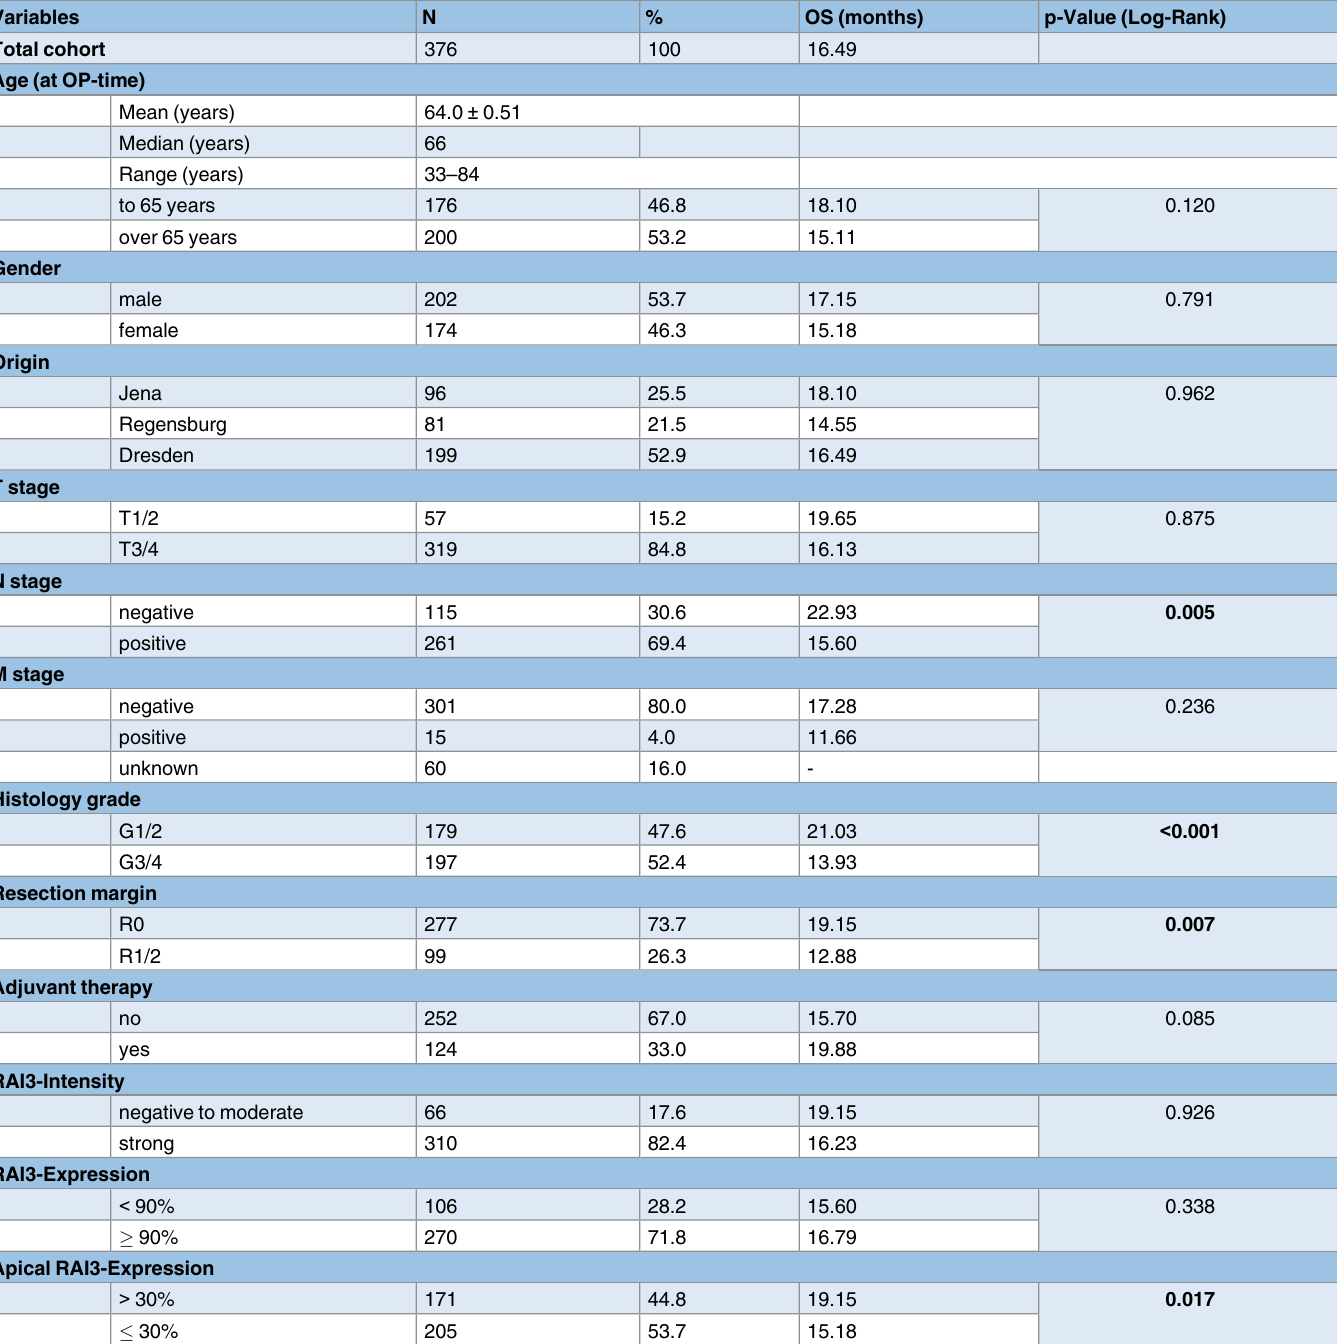
Table 1. Univariate analysis of clinico pathological variables of the 376 patients with pancreatic cancer analyzed on the TMA.